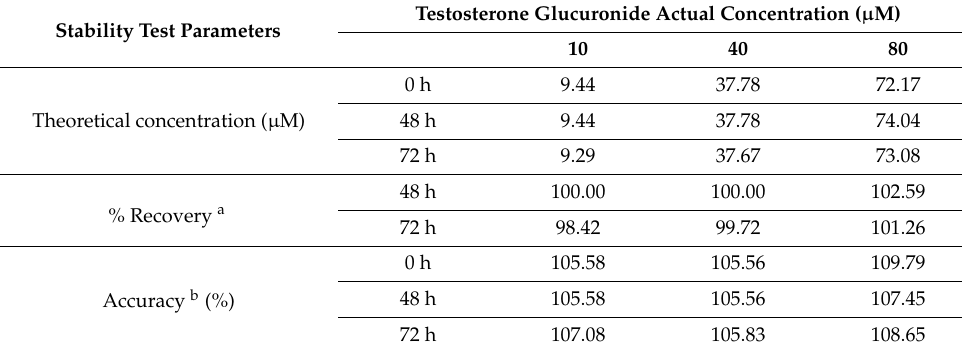
Table 11. Stability test outcome of testosterone glucuronide. Stability Test